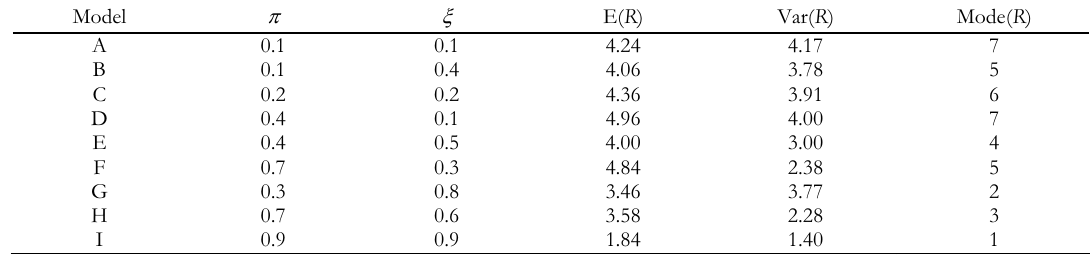
Models selected for the Monte Carlo experiment (m=7)